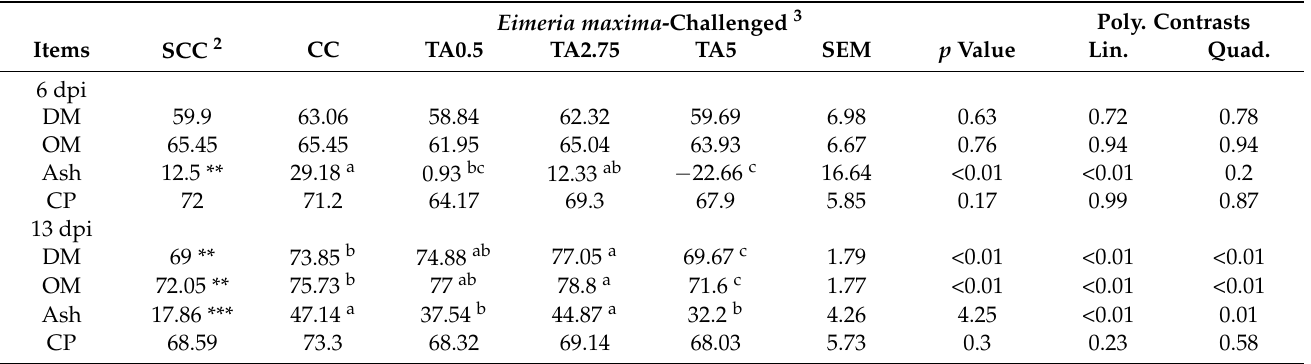
Table 8. Effects of tannic acid supplementation on apparent ileal digestibility of dry matter (DM), organic matter (OM), ash, and crude protein (CP) at 6 days post-infection (dpi) and 13 dpi in broilers infected with Eimeria maxima 1 . Eimeria maxima -Challenged 3